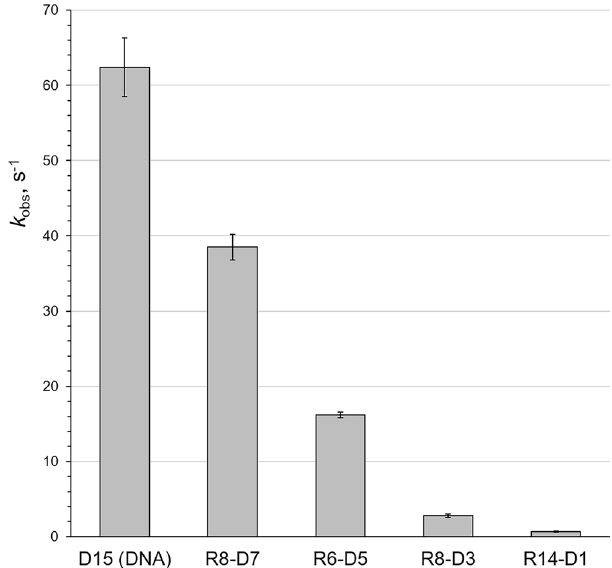
Figure 5. Efficiency of RNA–DNA primer extension by hPolε CD depends on the length of DNA tract at the 3 ′ -end. The k obs values are presented as bar graphs showing the mean ± SD (n = 3). The type of primer is indicated below the bar.